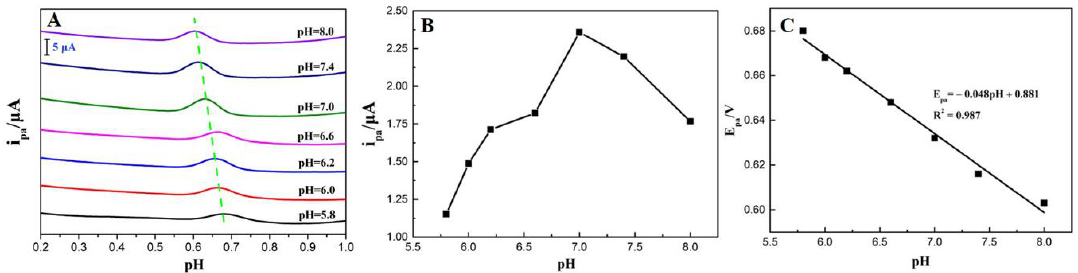
Figure 6. ( A ) DPV curves of Allura Red recorded at various pH; ( B ) The influence of pH on the anodic peak current of Allura Red; ( C ) Linear relationship between anodic peak potential and pH.